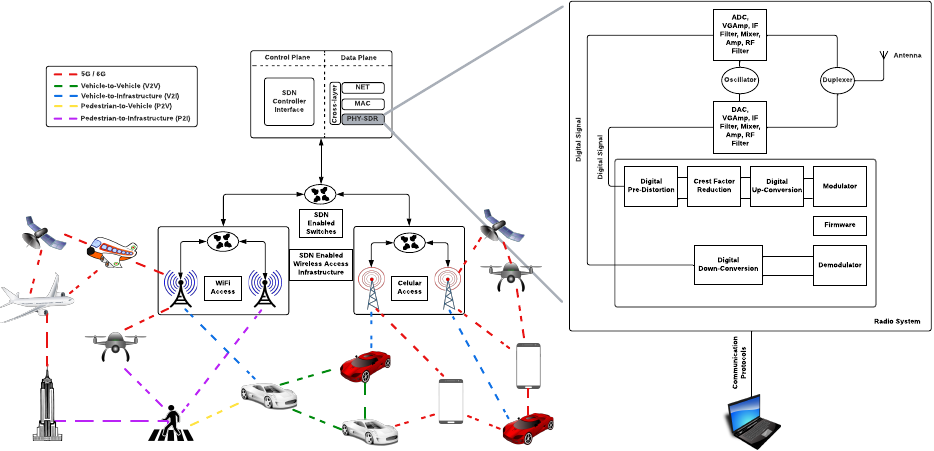
Figure 1. An operating environment of communication networks based on